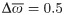
Dependence of spiral-wave stability on Δω.Pseudocolor plots of Vm illustrating the development of a spiral-wave instability for Δω¯=0.5 (top-row panels) and the sustenance of a stable spiral for Δω¯=0.4 (bottom-row panels). The parameter sets are as follows: top row, Δg = 0.5, gmin = 0.5 and Gi = GKr; bottom row, Δg = 0.5, gmin = 0.2 and Gi = Gto.